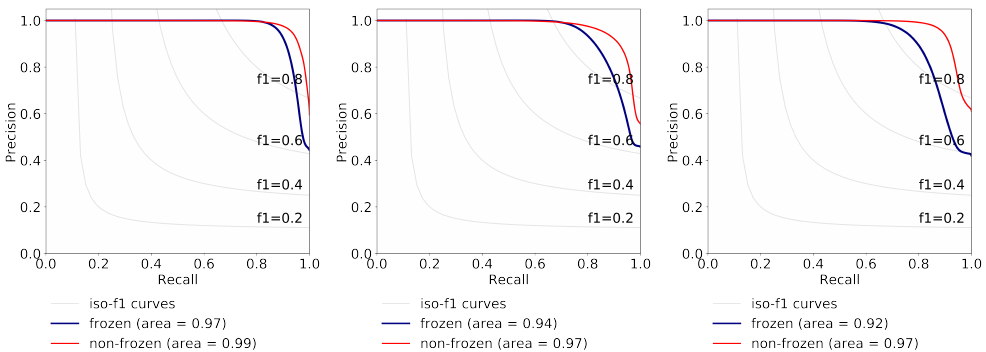
Figure 6: Precision-recall (PR) curves for lakes Sils (left), Silvaplana (middle), and St. Moritz (right) for winter 2017 - 18 . The iso-f 1 curve connects all points in the PR space with same F 1 score. Combined data of all 3 lakes from winter 2016 - 17 was used to train the model. Best if viewed on screen. Table 6: Per-class- and mean IoU values of frozen and non- frozen classes for each lake. The data of a lake from two winters ( 2016 − 17 and 2017 − 18 ) is tested using a model trained on the data from the other two lakes from both winters. Lake Sils Silvaplana St. Moritz IoU Non-frozen 96.7% 93.3% 85.6% Frozen 96.4% 92.7% 82.9% Mean 96.5% 93.1%